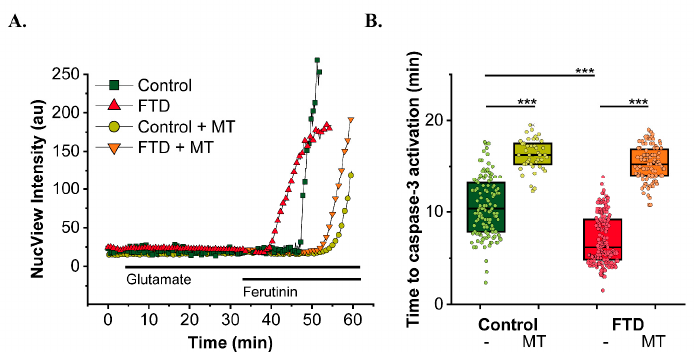
Figure 2. Mitochondrial antioxidants reduce FTD neurons vulnerability to mPTP opening. ( A ) Representative traces depict NucView intensity in iPSC-derived neurons from controls or FTD-related mutation 10+16 in MAPT treated or not with MitoTEMPO (MT) 100 nM and exposed to 50 μ m glutamate or the electrogenic Ca 2+ ionophore ferutinin [144,145]. Sudden increase in NucView fluorescence indicates caspase-3 activation. ( B ) Time to caspase-3 activation after Ca 2+ overload with ferutinin. Box represents median and 25, 75 percentiles. n = 126 neurons analysed in control, FTD n = 199, control + MT, n = 43, FTD + MT, n = 104. *** p < 0.001, Mann–Whitney test. Method: iPSC-derived neurons were loaded with the non-fluorescent caspase-3 substrate NucView488 for 15 min. NucView is cleaved upon caspase-3 activation inducing a sudden increase in green fluorescence. Images were taken on a Zeiss 710 LSM confocal microscope with an integrated META detection system.